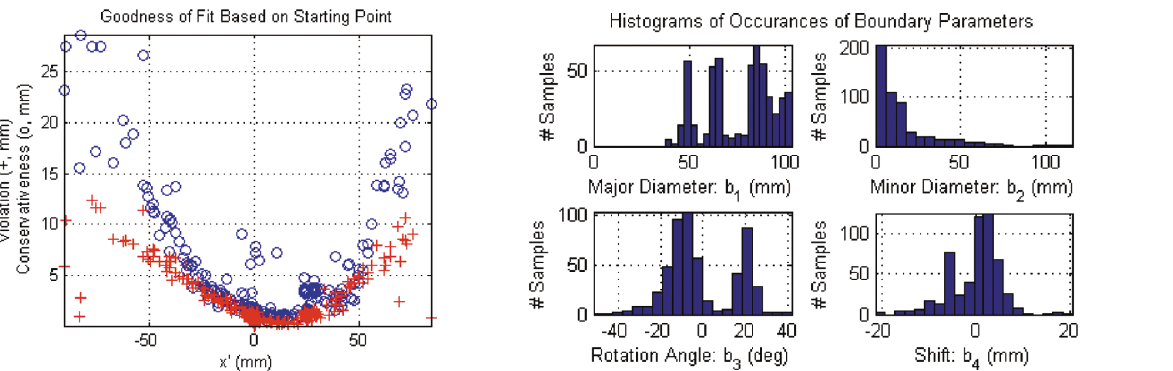
Fig. 15. Ellipses typically fit the path well, but get worse as deployments start further to the side. Violation (marked by + ) is the maximum dis- tance a data point is outside the bound, while conservativeness (marked by o) is the maximum distance for a point on the bound to the path.